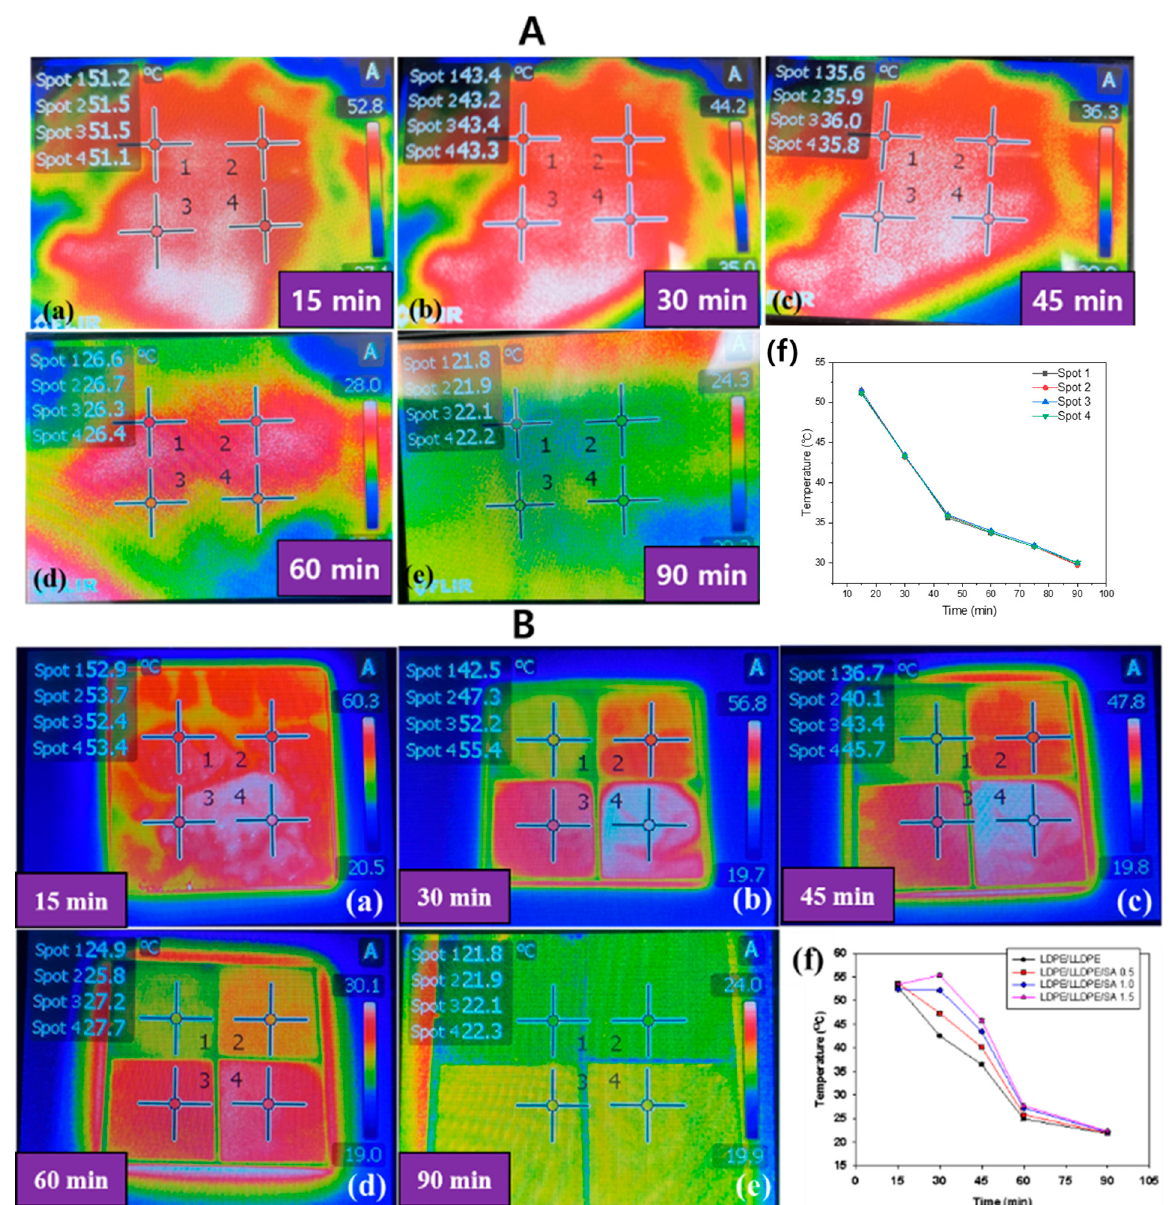
Figure 8. The infrared thermal images and temperature-time curve of ( A ) only the hot plate and ( B ) the prepared LDPE/LLDPE/SA (0-1.5%) films obtained by the hot plate. (a)–(e) are measuring time such as (a) 15 min, (b) 30 min, (c) 45 min, (d) 60 min, and (e) 90 min. (f) represented the temperature according to time.